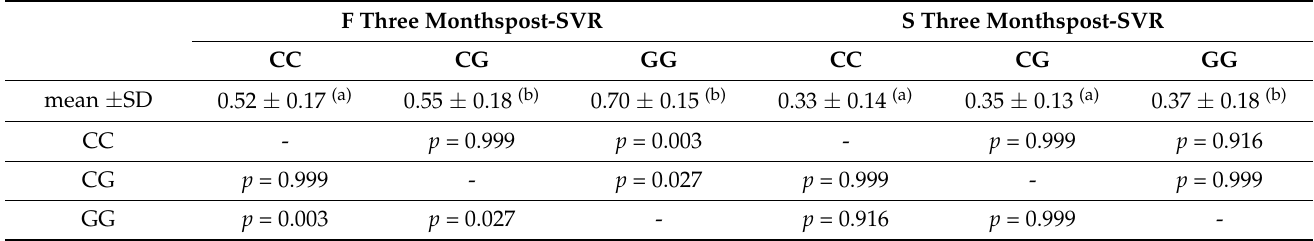
Correlated with the PNPLA3 polymorphism, fibrosis regression was more F — fibrosis; S — steatosis. (a) p <0.001 for paired samples t -test pre- vs. post-SVR. (b) p <0.05 for paired samples t -test pre- vs. post-SVR.